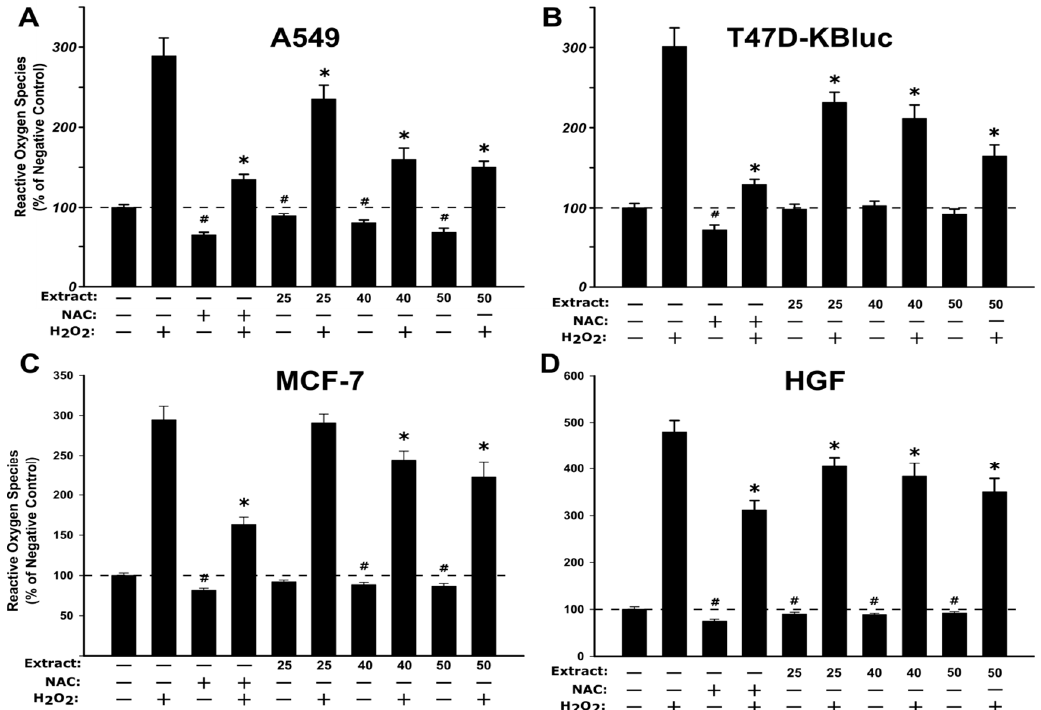
Figure 3. Antioxidant effect of the WSE evaluated using DCFH-DA (2 ʹ ,7 ʹ -Dichlorofluorescin Diacetate) assay on A549 ( A ), T47D-KBluc ( B ), MCF-7( C ) and HGF ( D ). The cellular model was pre-exposed to the extract (25, 40, and 50 µg/mL) or N-acetylcysteine (NAC) (20 mM) for 24 h, and further incubated with 50 µM DCFH-DA. The antioxidant effect of the WSE was evaluated after 2 h in stimulated (250 µM H 2 O 2 ) and un-stimulated conditions. The results are expressed as relative means ± standard deviations (six technical replicates for each of the three biological replicates) where the negative control (DMSO 0.2%) is 100%. The asterisks (*) indicate significant differences compared to the positive control (250 µM H 2 O 2 ) in stimulated conditions, while (#) indicate significant differences compared to the negative control in non-stimulated conditions (ANOVA + Tukey; p < 0.05).